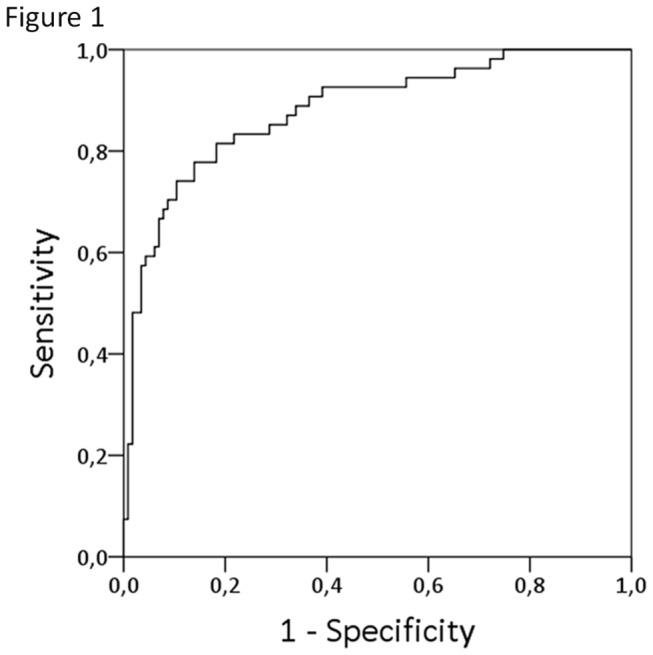
ROC of the multivariable model (AUC 0.88).